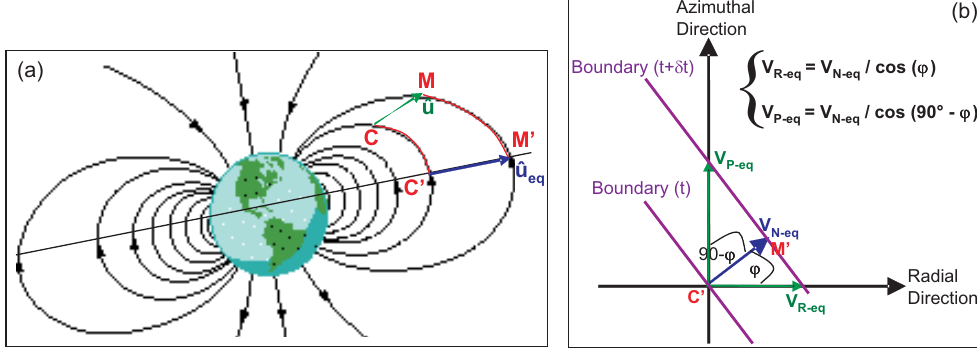
Fig. 1. (a) Projection along the magnetic field line of a vector u determined at the centre of mass C of the four satellites, until the magnetic field strength reaches a minimum (C 0 ): u eq . (b) Definition of three velocity vectors in the equatorial plane: the normal boundary velocity V N − eq , the azimuthal plasma velocity V P − eq and the apparent radial boundary velocity V R − eq (see text for more details).